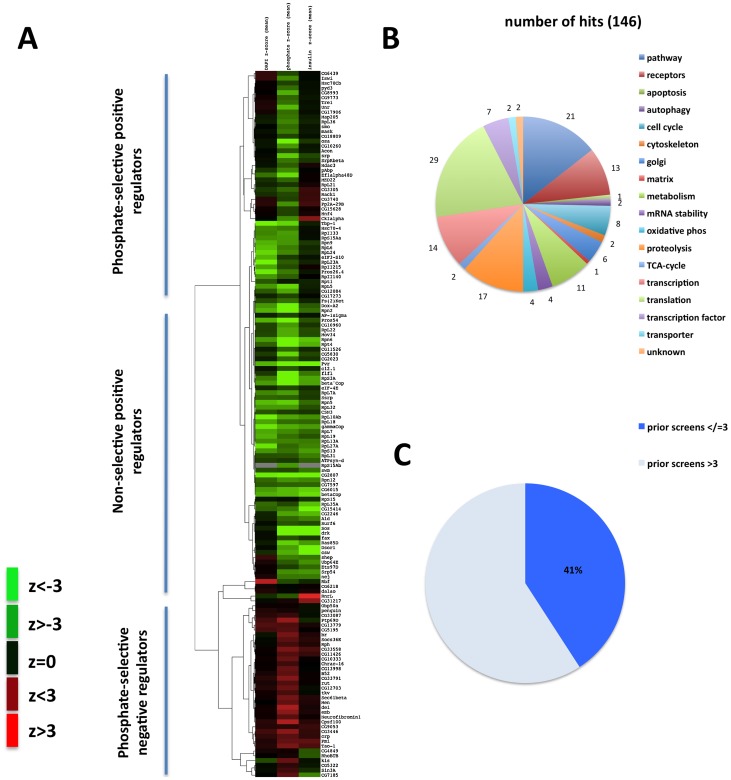
S2R+ genome-wide RNAi screen. A:heatmap of z-scores for 146 verified genes, cell count/well based on DAPI signal (first column), dpERK signal after 10 min. phosphate stimulation (middle column), and dpERK signal after 10 min. insulin stimulation (third column), green indicates positive regulators, red indicates negative regulators. B: Functional classification of 146 verified genes based on GO term categories using the DAVID tool (http://david.abcc.ncifcrf.gov/) [27], and FlyMine (www.flymine.org/) [28]. C: Number of genes identified in prior DRSC screens.